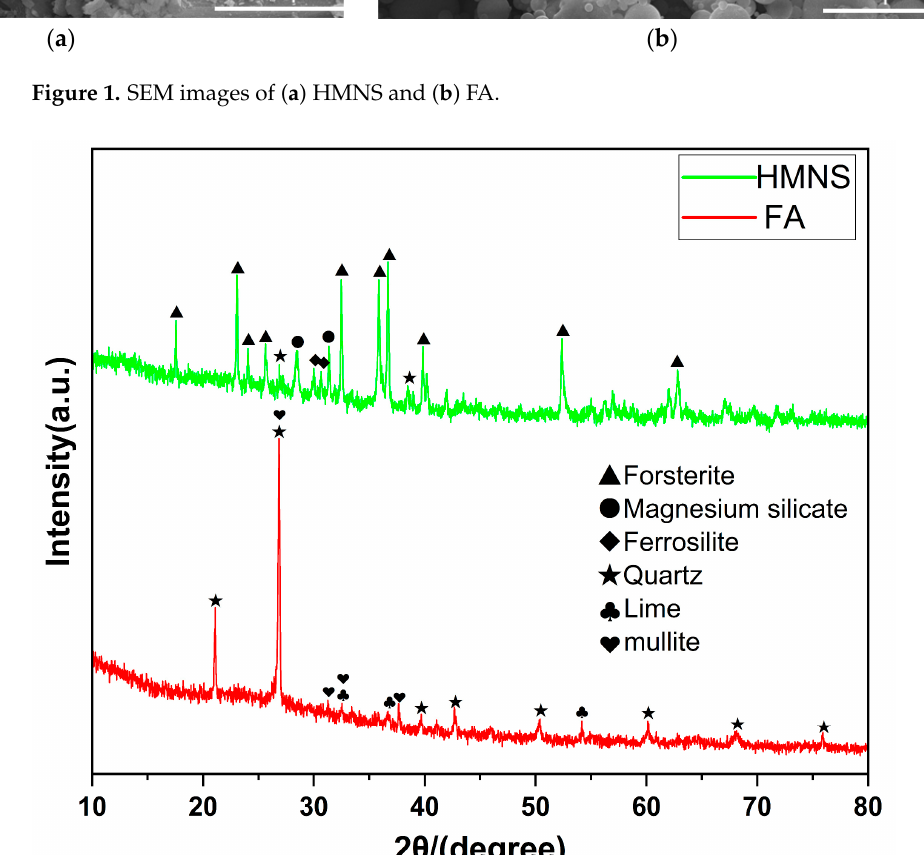
Figure 2. XRD patterns of HMNS and FA. Table 1. Chemical composition of HMNS and FA.